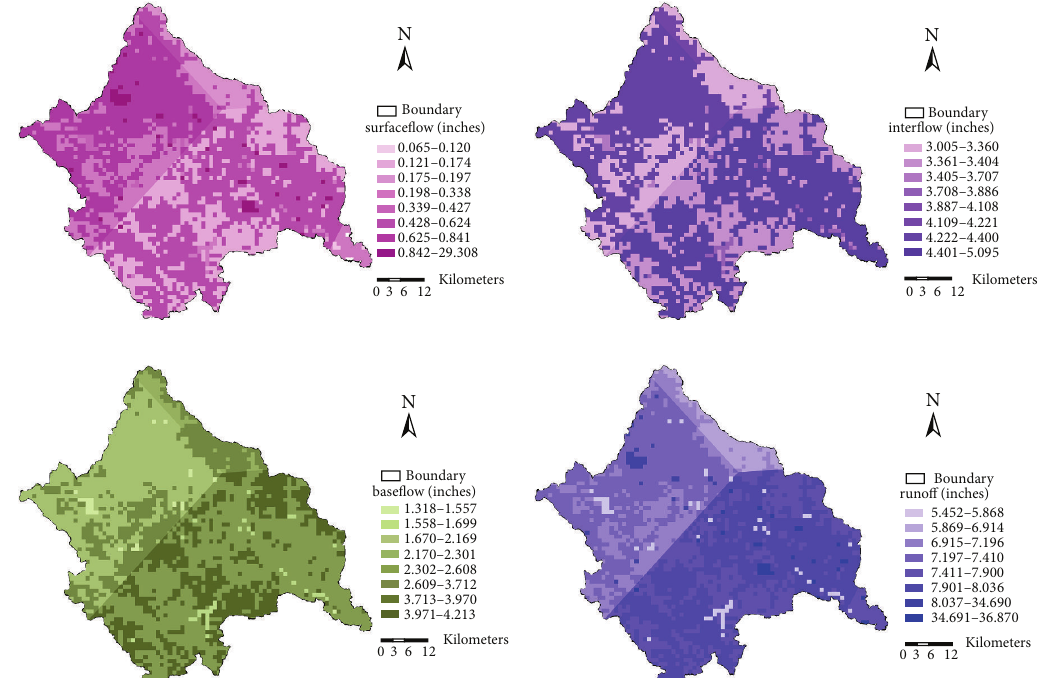
Figure 7: Spatial distribution of different hydrological simulation results for annual average between 2001 and